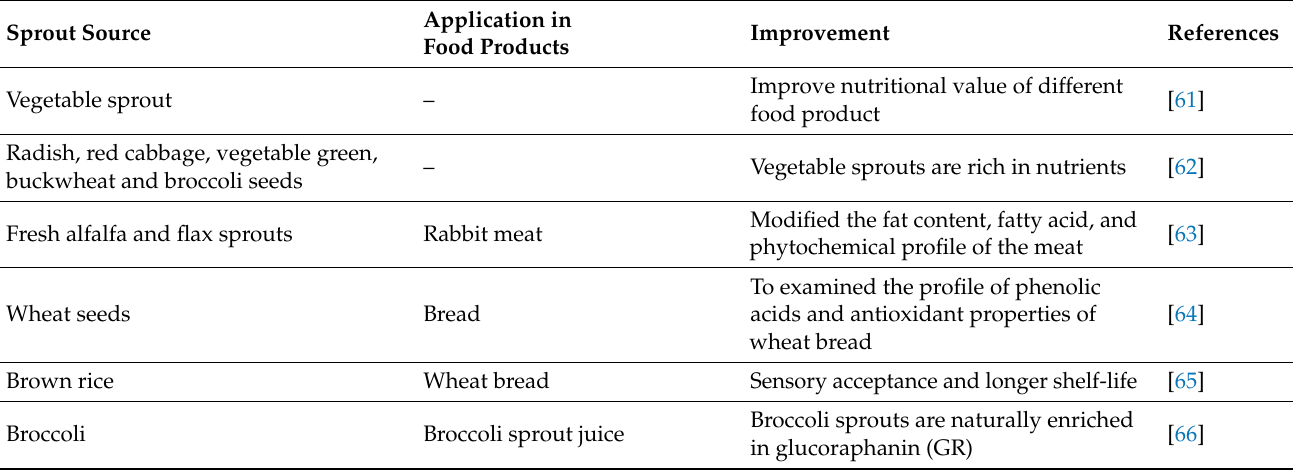
Table 2. Food applications of vegetables